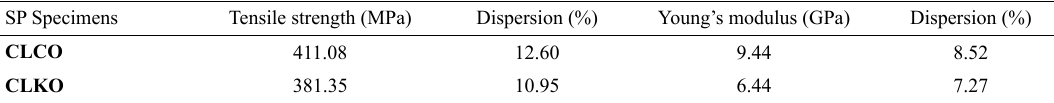
Figure 2. Stress x Strain curves. (a) CLKO specimens. (b) CLCO specimens. Table 2. Tensile strength and Young’s modulus. Original